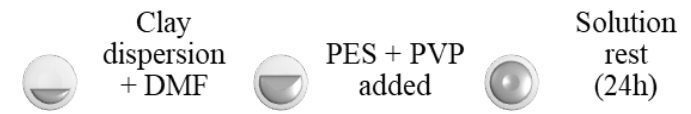
Figure 2. Flowchart of the wiring solution preparation methodology.